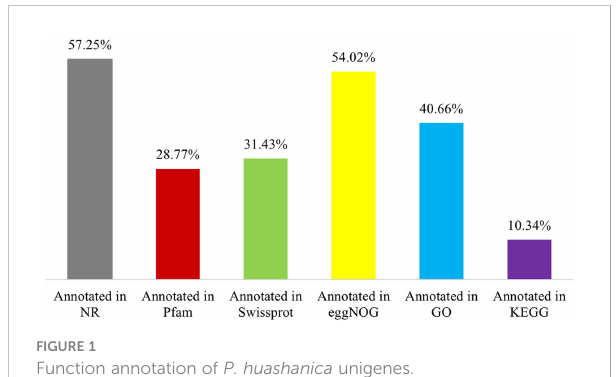
FIGURE 1 Function annotation of P. huashanica unigenes.